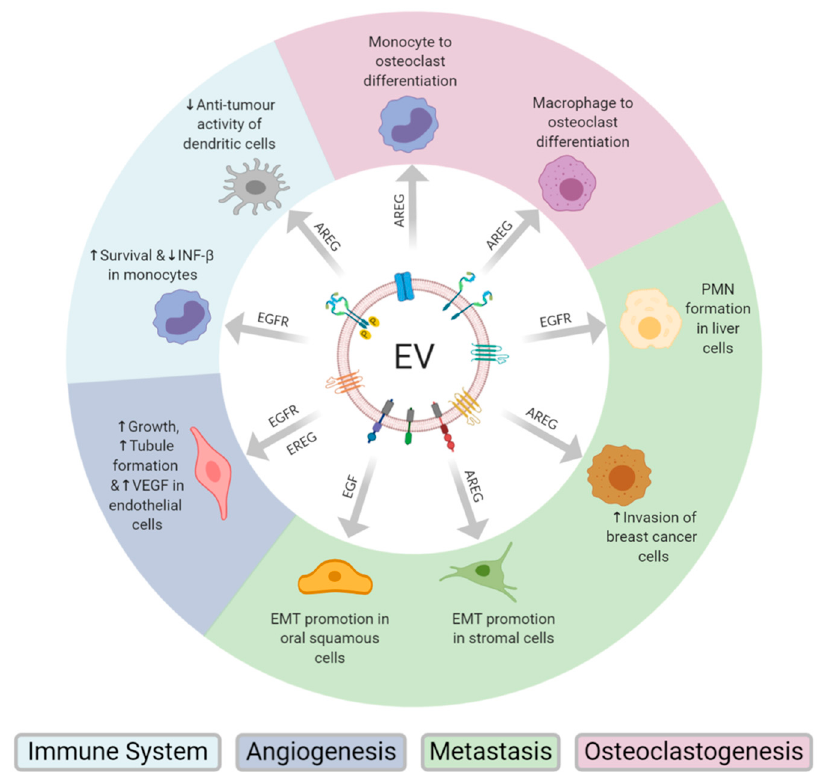
Figure 2. Schematic representation of the transfer of epidermal growth factor receptor, epidermal growth factor, amphiregulin or epiregulin from EVs to recipient cells of the immune system, tumour microenvironment or cells at metastatic sites. This EV-meditated transfer of EGFR or EGFR ligands has been shown to modulate the immune system, promote angiogenesis, metastasis and osteoclastogenesis in cancer.